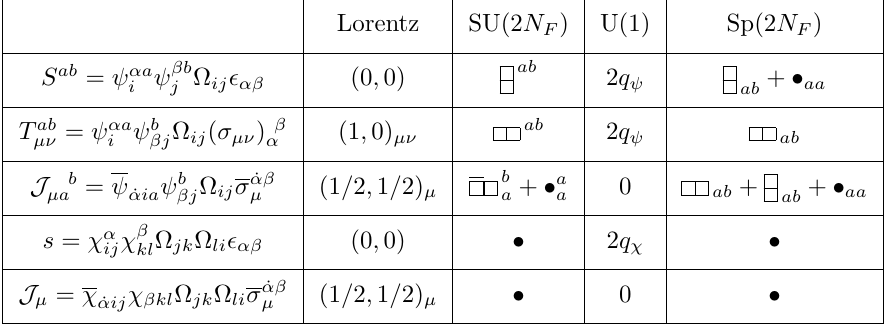
Table 3 . The fermion bilinear operators, and their transformation properties with respect to Lorentz and to the flavour symmetry, before and after SSB. One can straightforwardly replace χ with χ 0 everywhere, if